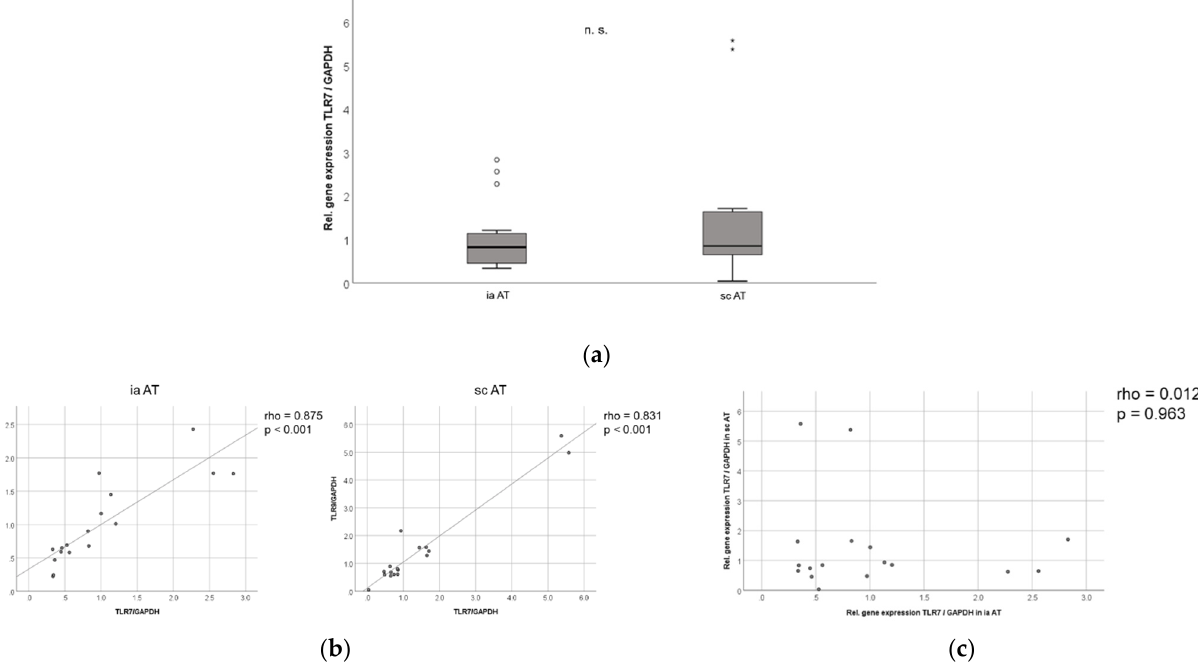
Figure 6. TLR7 is expressed with similar levels in murine subcutaneous and intra-abdominal adipose tissue and strongly correlates with TLR9 mRNA expression. Intra-abdominal (ia) and subcutaneous (sc) adipose tissues (AT) were isolated from female ( n = 5) and male ( n = 12) TLR9 wt/wt mice, and TLR7 gene expression (normalized to GAPDH expression) was analyzed using RT-PCR. ( a ) No significant differences were observed in TLR7 expression levels between intra-abdominal and subcutaneous AT ( n = 17); ( b ) there was a strong correlation of TLR7 and TLR9 mRNA levels in both fat compartments ( n = 17); ( c ) no correlation was observed between intra-abdominal and subcutaneous TLR7 expression levels ( n = 17). (n.s.—not significant).